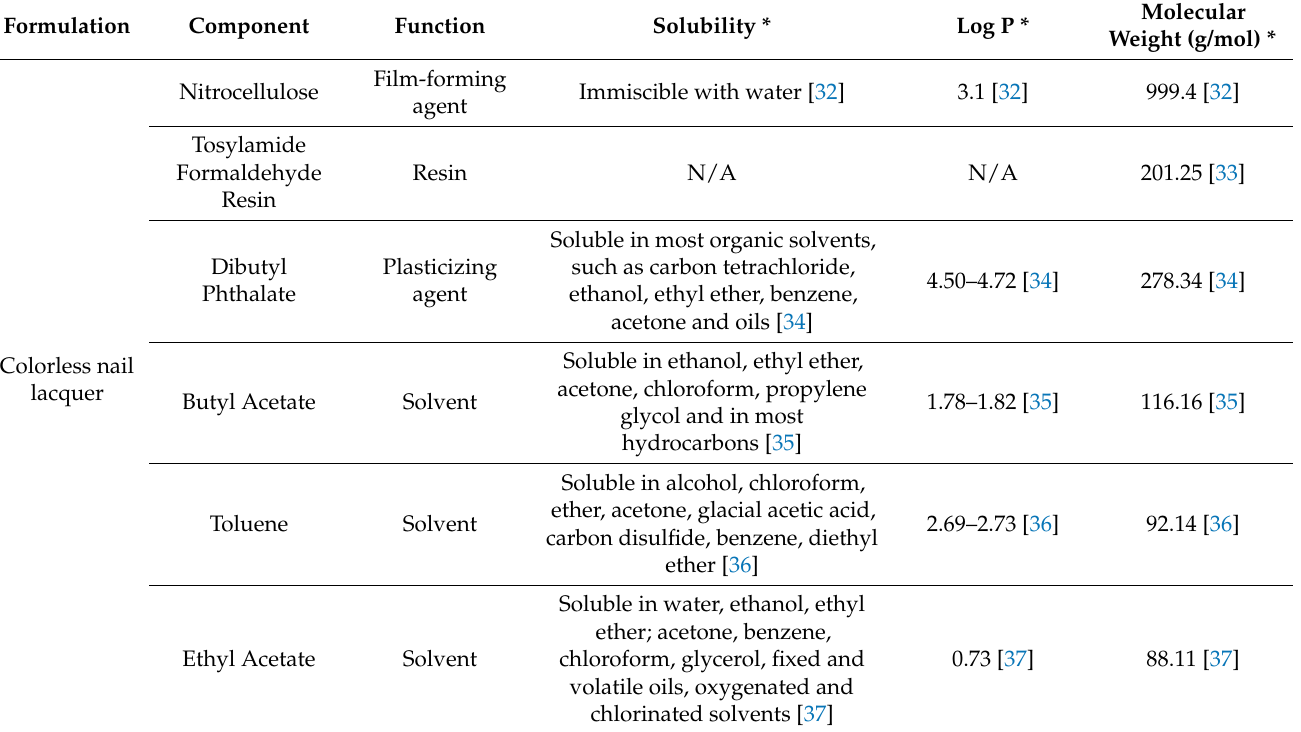
Table 1. Description of the AmB-loaded nail lacquer